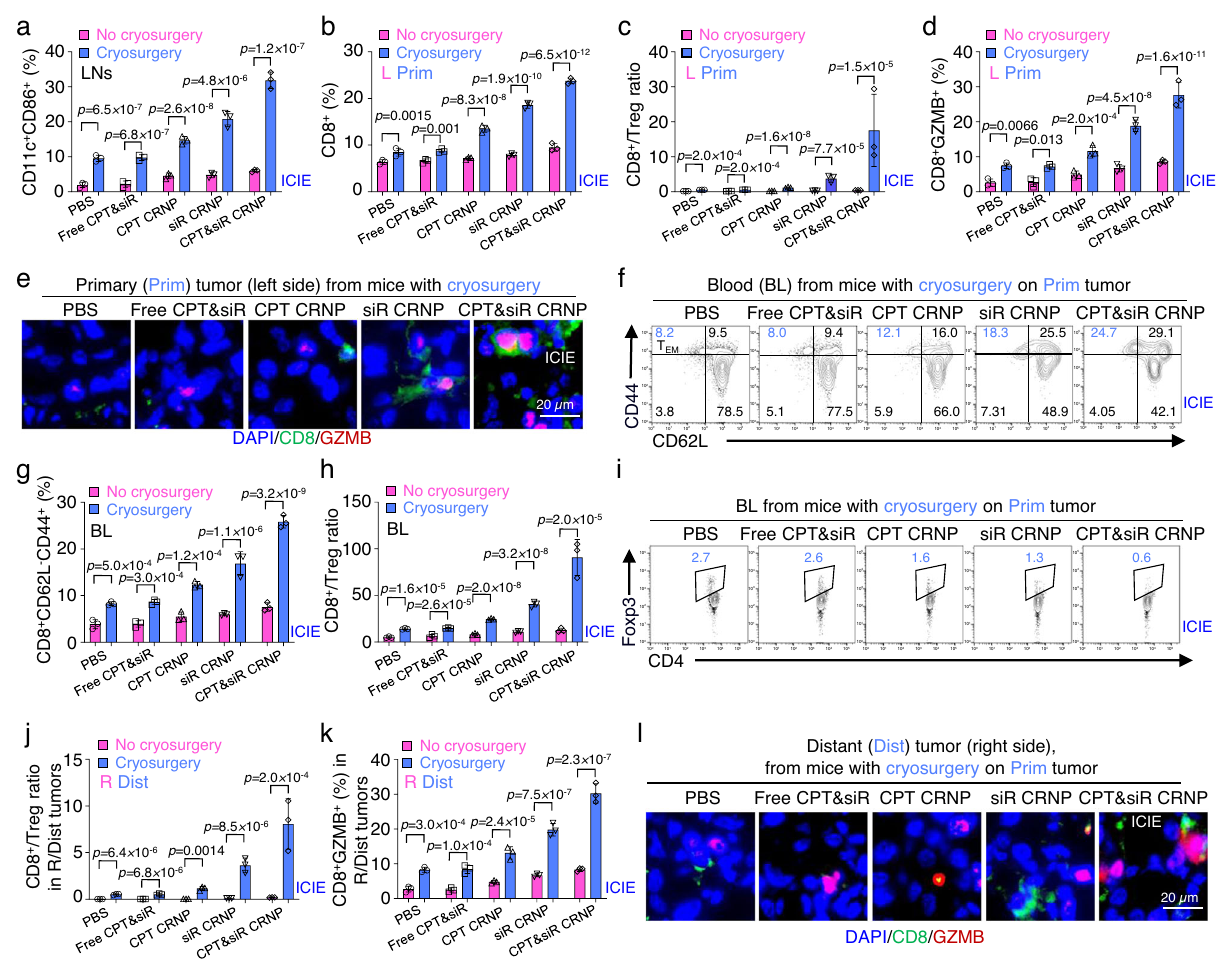
Fig. 6 | ICIE stimulates antitumor immune responses in primary tumors and activates the memory immune response against distant tumors. a – d Quantitative fl ow cytometry data of matured DCs (CD11c + CD86 + ) in inguinal lymphnodes(LNs, a ),andpercentageofin fi ltratedCD8 + Tcells( b ),ratiosofCD8 + / Tregcells( c ),and percentageofcytotoxicTcells(CTLs,CD8 + GZMB + , d )inprimary (Prim) tumors of mice with cryosurgery and L (left side) tumors of mice with no cryosurgery ( n =3 mice). e Representative immuno fl uorescence images of in fi l- trated CTLs in primary (Prim) tumors from mice with cryosurgery ( n =3 mice). f Representative fl ow cytometryplots showing the percentage ofeffector memory T cell (T EM , CD3 + CD8 + CD44 + CD62L − ) in blood (BL) collected from mice with cryo- surgery and injection of one of the various formulations. g Quantitative fl ow cytometry data of T EM in blood of mice with/without cryosurgery and injection of one of the different formulations ( n =3 mice). h CD8 + /Treg ratios in the blood of mice with/without cryosurgery and injection of one of the different formulations ( n =3 mice). i Representative fl ow cytometry plots of Treg cells in blood collected